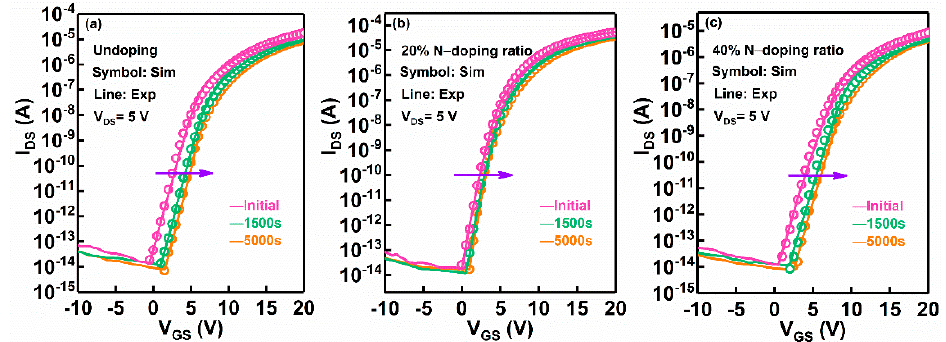
Figure 4. Depth profile of nitrogen in a-IGZO film deposited under 20% N-doping ratio and 40% N-doping ratio. Table 1. Densities of key defect model parameters for a-IGZO TFT fitted after different N-doping ratios.